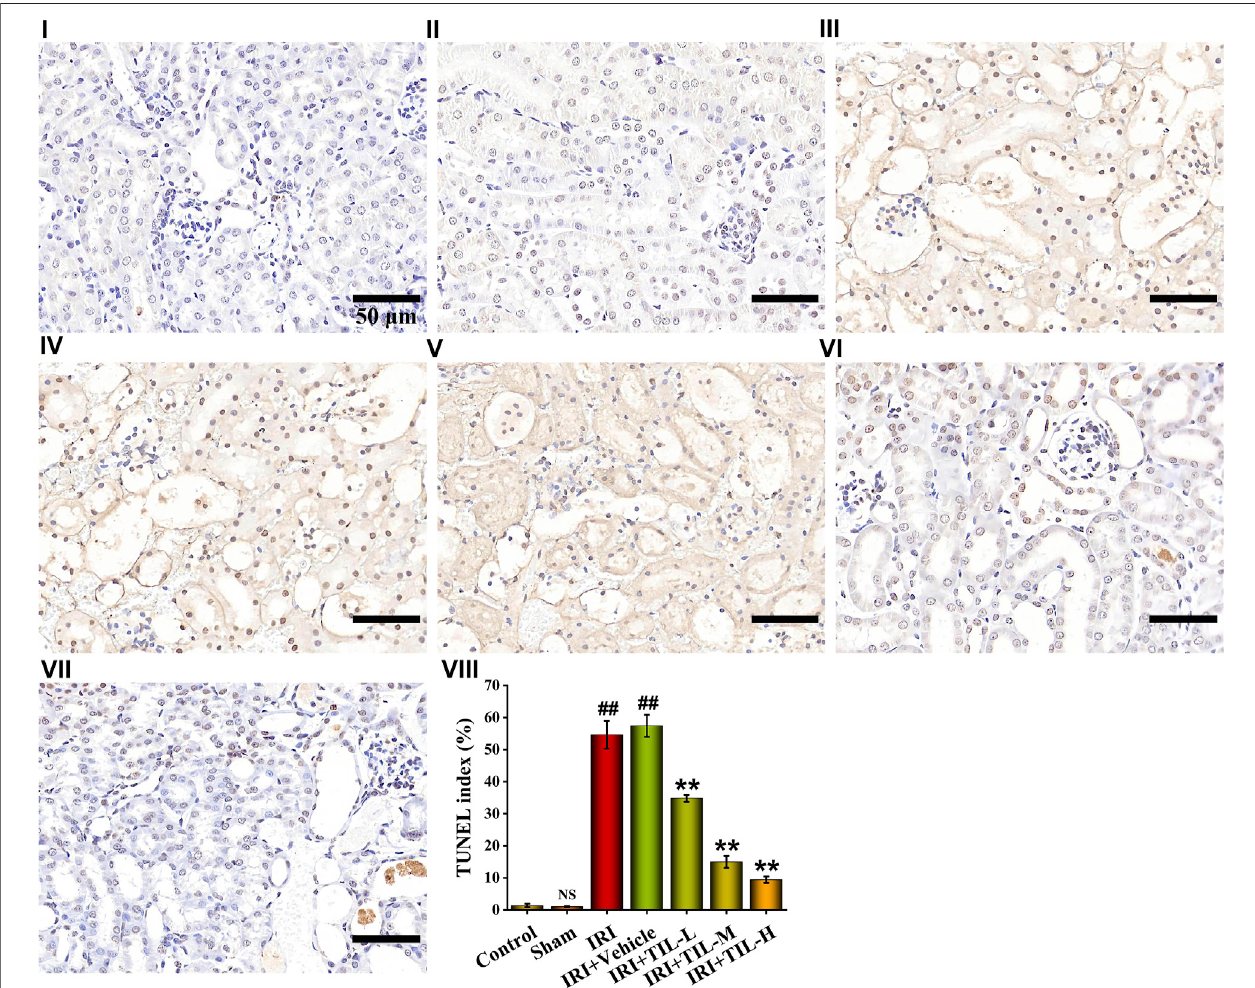
FIGURE3| TUNELassessmentofdifferenttreatmentgroups.TUNELimagesofkidneysectionsunderthemagni fi cationsof400×showedthenumberofapoptotic cellsinthedifferentgroups,whichwerestainedwithblueandbrown.TUNELindexwereproportionsofTUNEL-positivenucleitototalnucleiinRTECsofmice.Scalebar, 50 μ m( Ⅰ :controlgroup; Ⅱ :shamgroup; Ⅲ :IRIgroup; Ⅳ :IRI+vehiclegroup; Ⅴ :IRI+TIL-Lgroup; Ⅵ :IRI+TIL-Mgroup; Ⅶ :IRI+TIL-Hgroup;and Ⅷ :statisticalresultsofthe TUNEL index). n =3 per group. All data are shown as mean ± SD. ## p < 0.01 versus control ; NS P > 0.05 versus control. **p < 0.01 versus